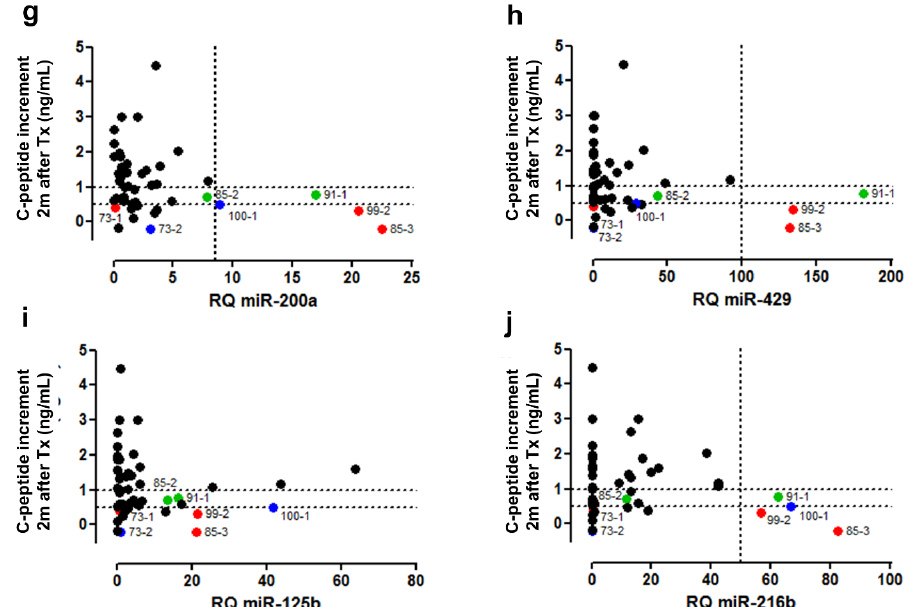
Figure 6. Diagnostic performance of microRNAs to predict poor secretory graft outcome 2 months post-transplantation. ( a ). Molar miR-375 levels (pmol/L) in plasma as measured by calibrated RT-PCR assay 1 h after islet graft infusion in n = 46 T1D recipients ( X -axis) as a function of the graft-induced gain in endogenous C-peptide production (C-peptide increment). Dotted lines indicate operator-chosen thresholds for acceptable graft function at C-peptide increment of 0.5 ng/mL and 1 ng/mL. Further analyses were done taking C-peptide < 0.5 ng/mL as a dichotomous indicator of poor outcome. Generally, 1 h post-transplant levels of miR-375 and GAD65 (not shown, [9]) correlate linearly with the number of implanted beta cells and C-peptide content of the graft. Individual post-transplant patient samples that are outliers on these correlations, indicating excessive beta cell destruction, are numbered and marked as colored dots throughout all panels: outliers for GAD65 (blue dots), miR-375 (green dots) or both (red dots). ( b ). Linear correlation (95% confidence interval as dotted lines) of post-transplant miR-375 values expressed as RQ values (see methods) and molar levels measured by calibrated PCR assay. Panels ( c – j ): RQ values of the indicated microRNAs 1 h post-transplant for all n = 46 transplant events as a function of C-peptide increment 2 months post-transplant. In case the distribution of RQ values of any microRNA shows statistical outliers, then this threshold is marked with a dotted line on the X -axis.